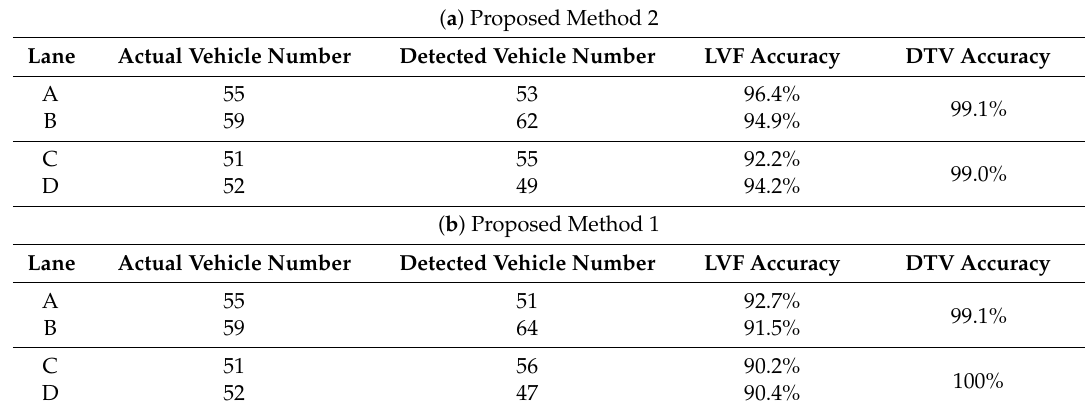
Table 6. Results of LVF and DTV detection during 9:10–9:20 AM (rush-hour traffic) using ( a ) proposed method 2 and ( b ) proposed method